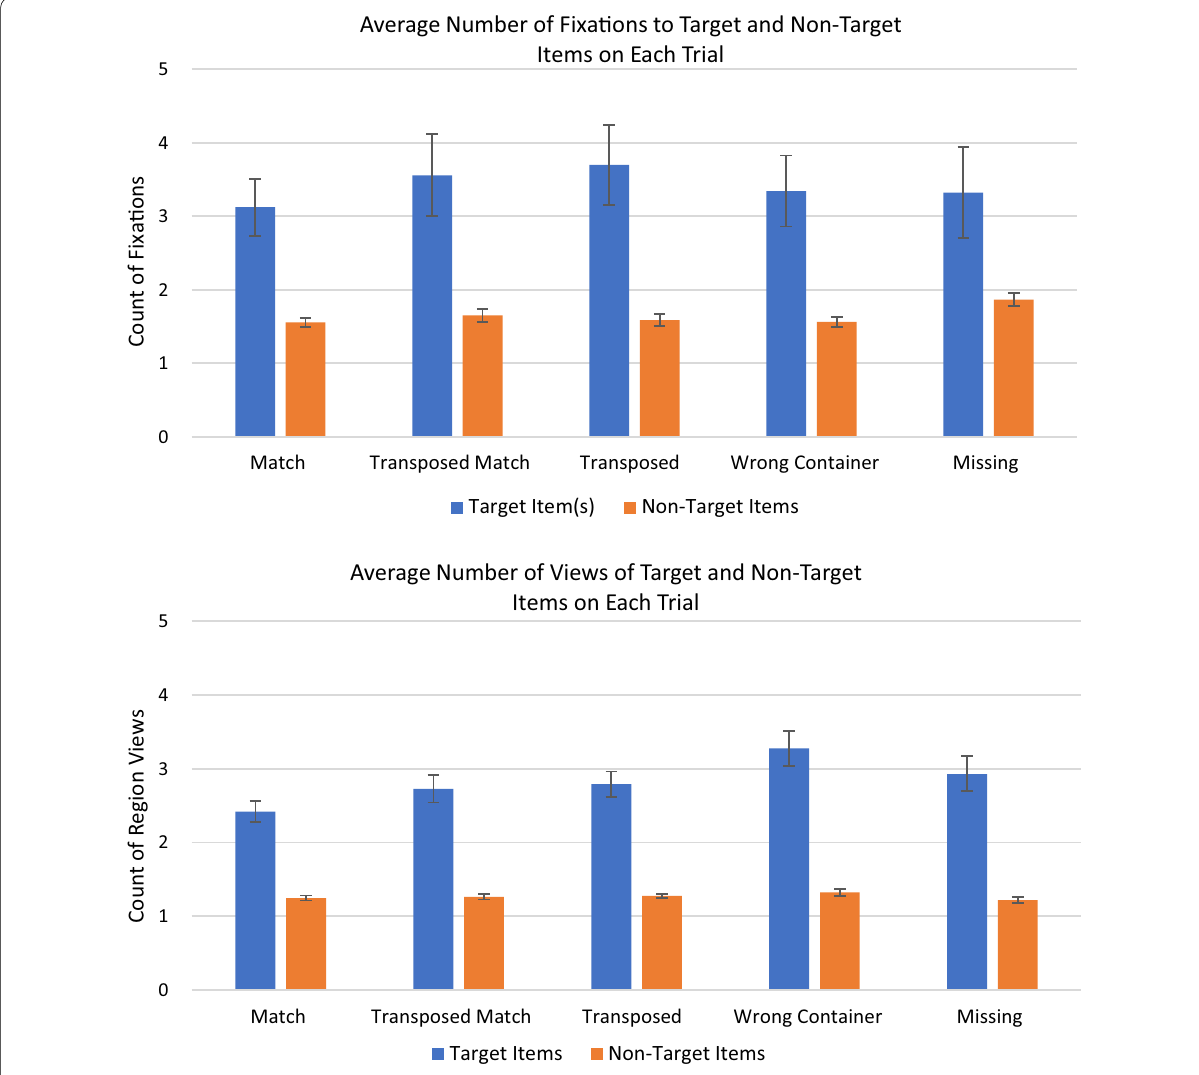
Fig. 7 The average number of fixations to target items per trial for the eye tracking experiment (top) and the artificial foveation experiment (bottom). Error bars show the standard error of the